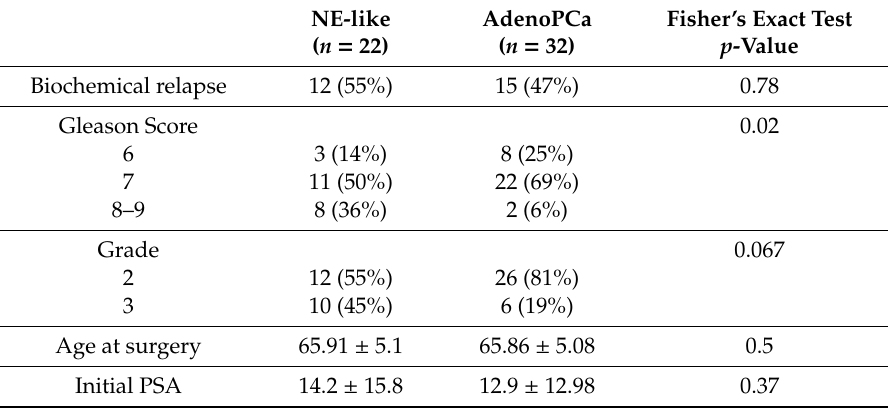
Table 1. Distribution of clinical features in NE-like vs. AdenoPCa samples.